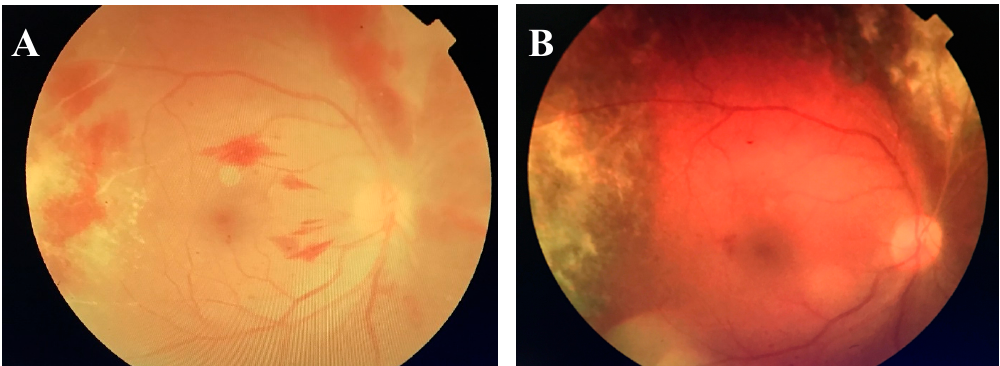
Figure 2. Fundus of patient with CMV retinitis. ( A ) Before antimicrobial treatment, the patient had vitritis grade 1, retinitis in the temporal periphery, vasculitis, retinal hemorrhages and optic disc swelling. ( B ) After antimicrobial treatment, the fundus shows retinal